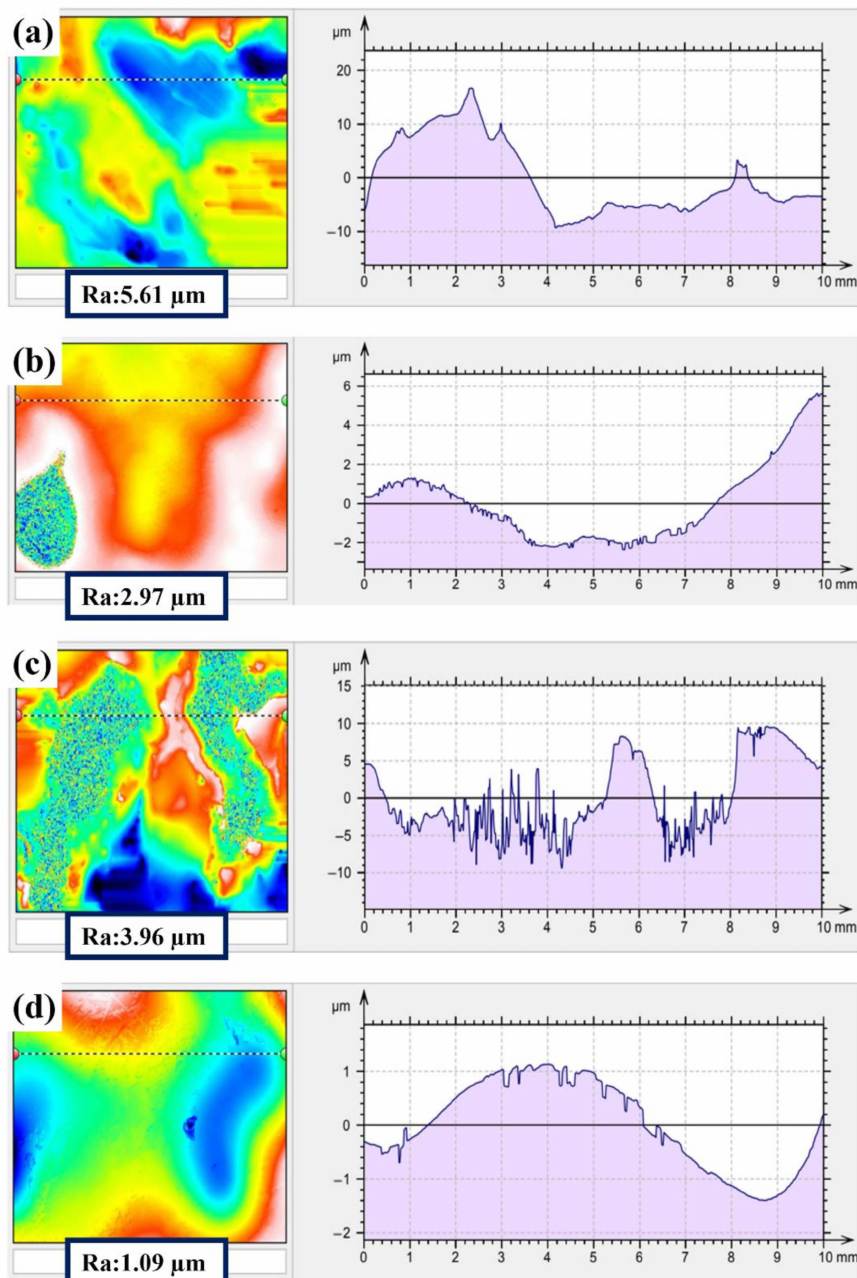
Figure 6. 3D white light diagram for ( a ) NAPEP10, ( b ) NAPEP20, ( c ) APEP10 and ( d ) APEP20 samples. The electropolishing process uses a constant voltage so duration is the control variable that affects surface roughness. The roughness–time curves for durations of 5 min, 10 min, 15 min and 20 min are shown in Figure 7. The surface roughness of AP samples obviously decreases as operating time increases so OA activation must be used as a pre-treatment for